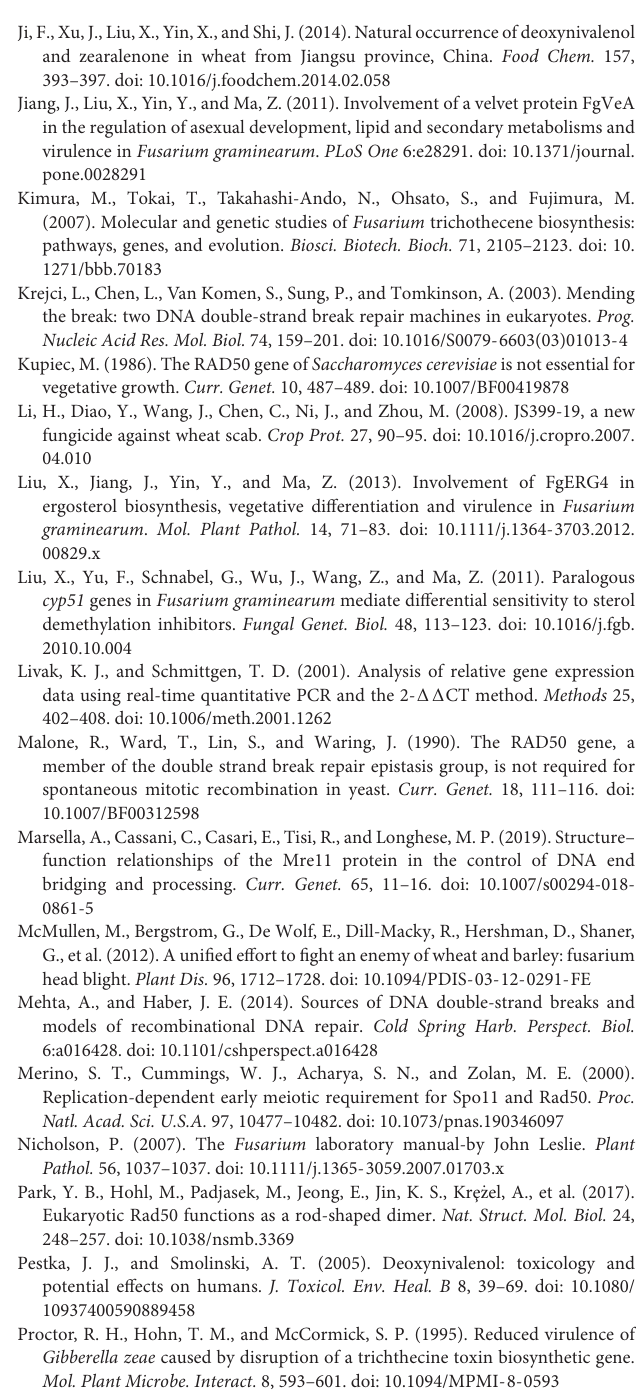
FIGURE S2 | Comparison of FgRad50 with homologs from Homo sapiens (HsRad50) and Triticum turgidum (TtRad50). Alignments of amino acid sequences of FgRad50 among homologs from HsRad50 and TtRad50. Genedoc software was used to highlight identical (black shading) or similar (gray shading) amino acids. TABLE S1 | PCR primers used in this